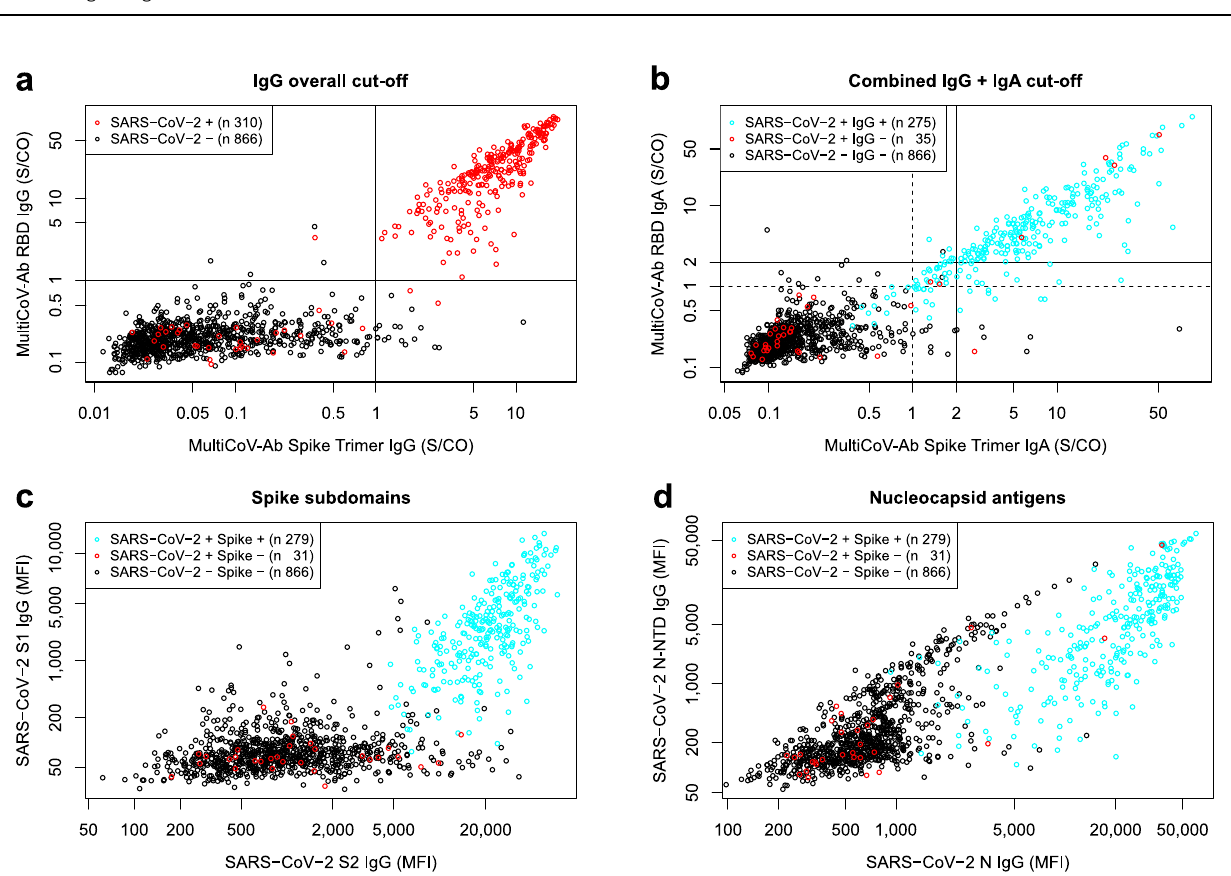
Fig. 2 Combination of 2 spike protein variants and isotype pro fi ling by multiplex assay increases accuracy to identify SARS-CoV-2 antibody-positive individuals. a , b Scatterplot detailing MultiCoV-Ab cut-offs. Signal to cut-off (S/CO) values are displayed for Spike Trimer against RBD on a logarithmic scale. For IgG ( a ), cut-offs are visualized by straight lines and SARS-CoV-2-infected and uninfected samples are separated by color (black circles – SARS- CoV-2-uninfected; red circles – SARS-CoV-2-infected). For IgA ( b ) cut-offs are visualized as dashed lines and S/CO of 2 used for the combined cut-off is shown as straight lines. SARS-CoV-2-infected samples are split into IgG-positives and -negatives by color as indicated in the plot. c , d Scatterplots display IgG response to additional SARS-CoV-2 antigens contained in the MultiCoV-Ab panel: MFI for spike subdomains S1 vs S2 ( c ) or nucleocapsid antigens N vs N-NTD ( d ) are displayed on a logarithmic scale. SARS-CoV-2-uninfected samples are distinguished from SARS-CoV-2-infected and MultiCoV-Ab classi fi cation into positives or negatives as indicated by color. Source data are provided as a Source Data fi le.